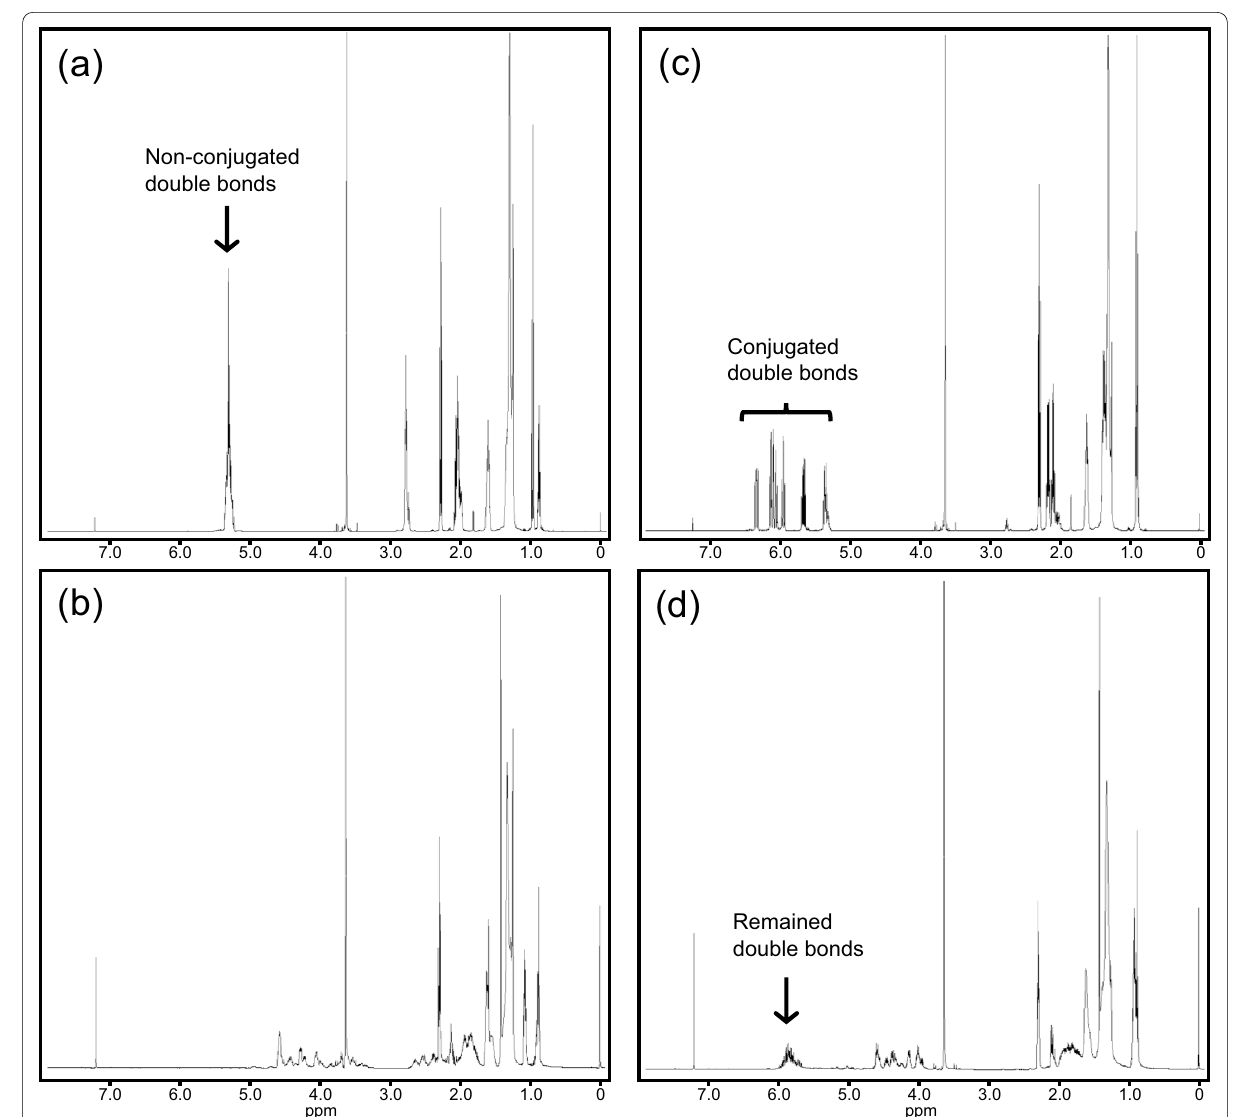
Fig. 1 Spectra of BDF and halogenated BDF obtained with the Wijs method: a perilla BDF, b halogenated perilla BDF, c tung BDF, and d halogenated tung